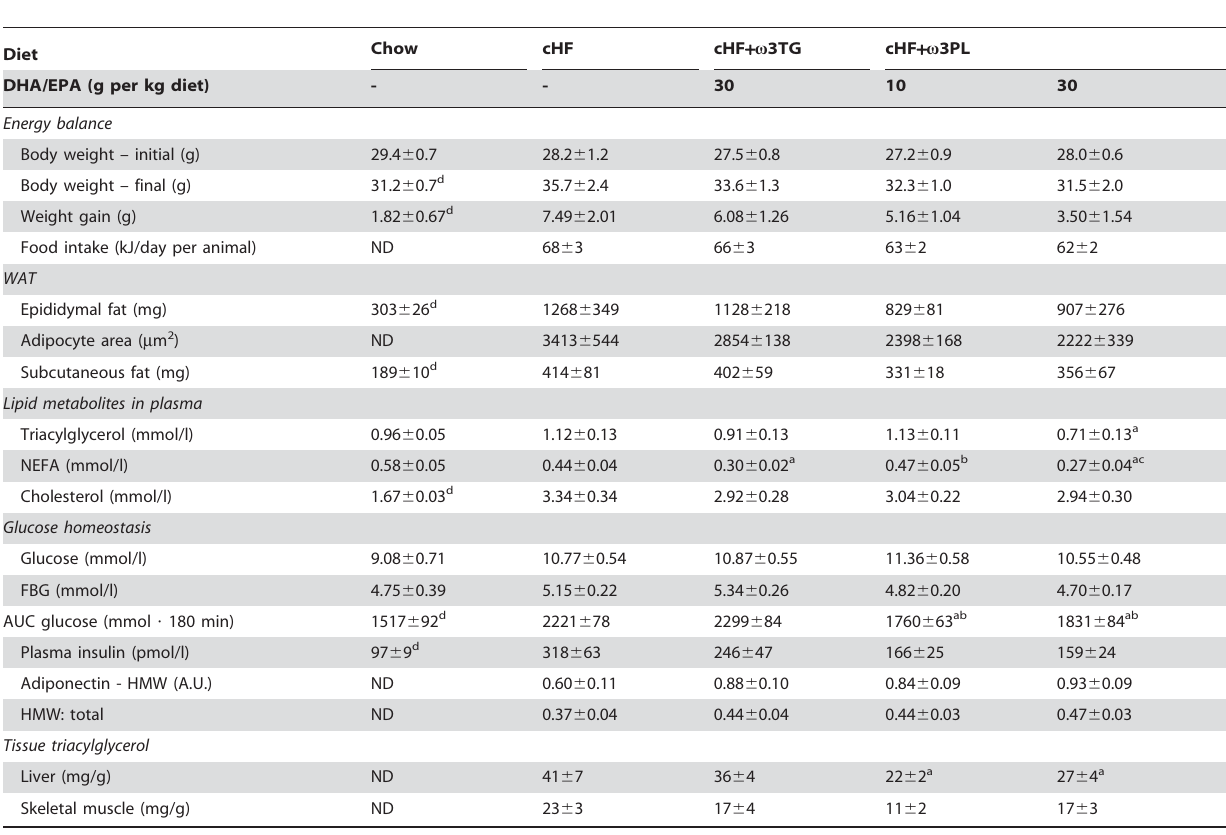
Table 1. Prevention of obese phenotype by dietary LC n -3 PUFA administered as either triglycerides or